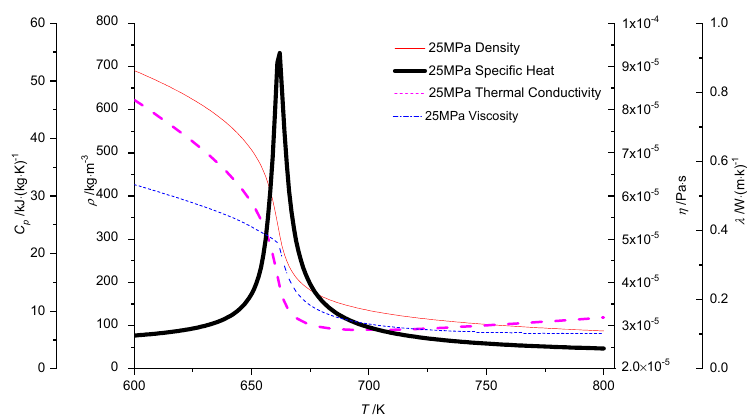
Figure 4. Variation of themophysical properties at P = 25 MPa.